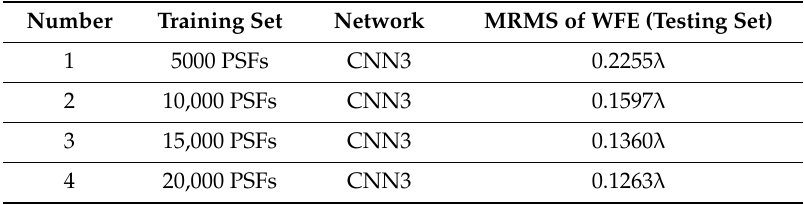
Table 2. The results of the simulations using di ff erent sample sizes.